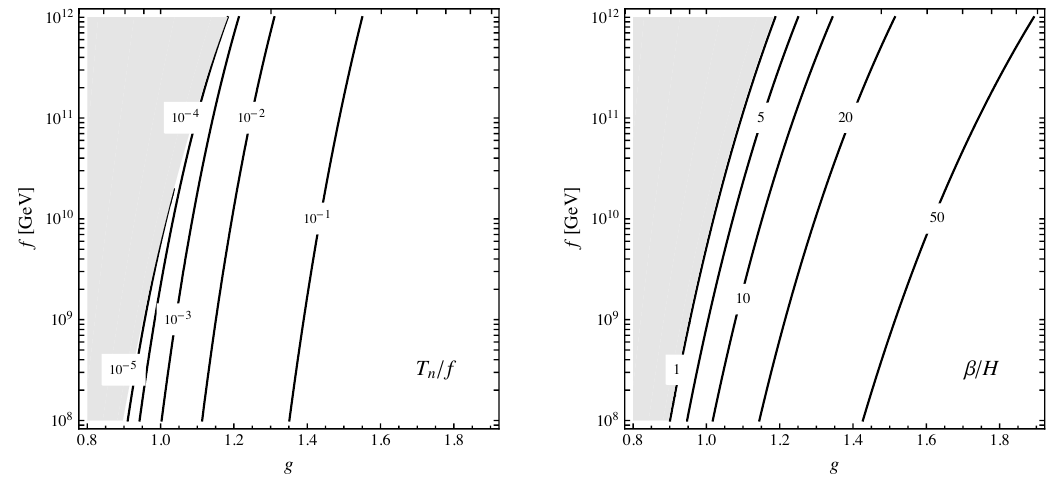
Figure 9 . Contour lines of the nucleation temperature T n =f (left plot) and the (cid:12)=H parameter (right plot) in the gauged weakly coupled model. In the gray regions nucleation never happens. Open